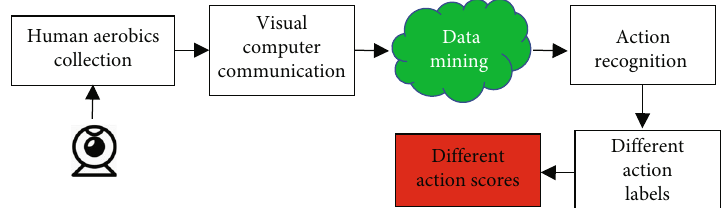
Figure 1: the pipeline of our proposed aerobics sports recognition system.